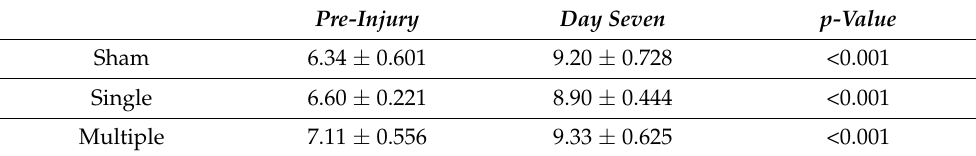
Table 3. Summary of animal weight averages (in kilograms) for pre-injury and Day Seven post-injury and analysis results. Values represent the calculated group average ± standard error and the p -value for Paired-Sample t